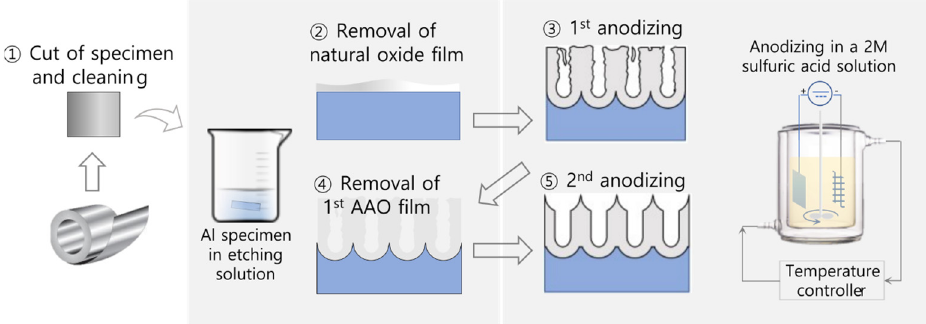
Figure 1. Schematic illustration of the two-step anodizing process